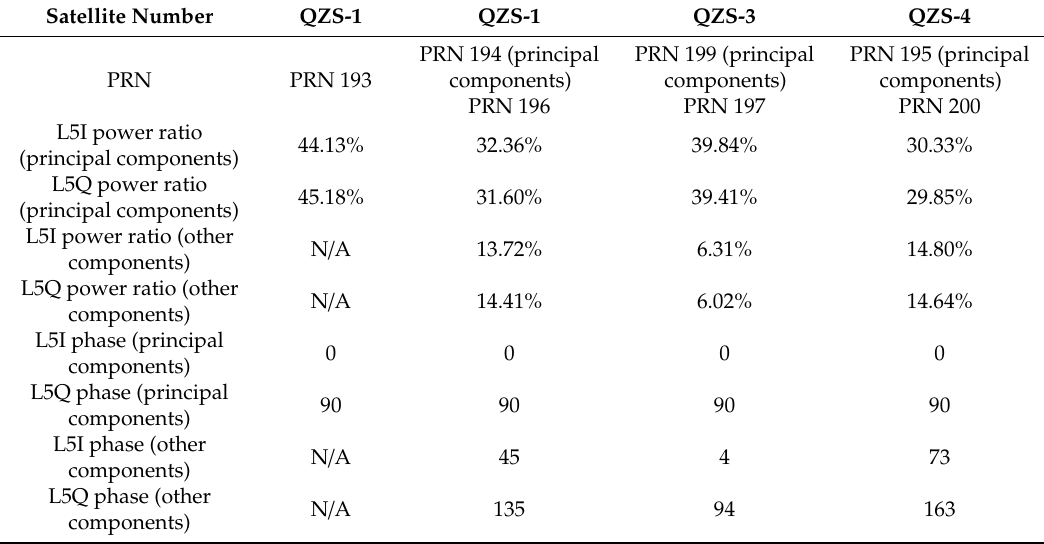
Table 3. QZSS satellite L5 frequency signals composition analysis.